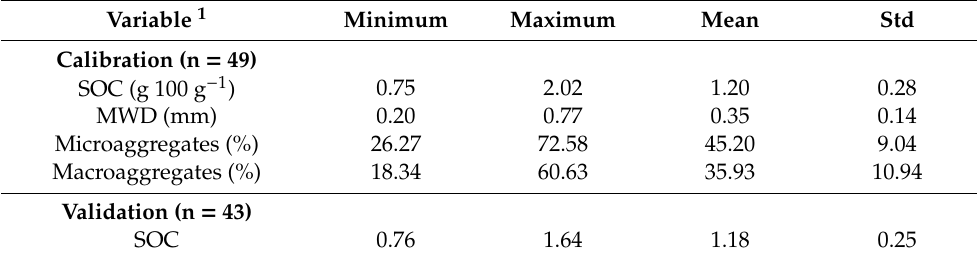
Table 1. Descriptive statistics of the SOC and aggregate stability indexes for the calibration and validation datasets.